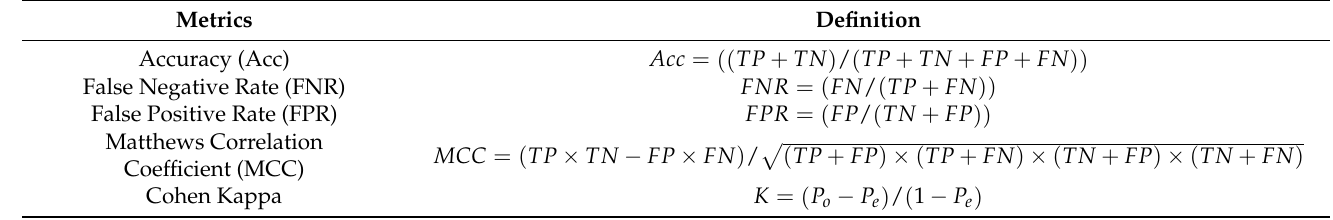
Table 4. Mathematical definition of performance